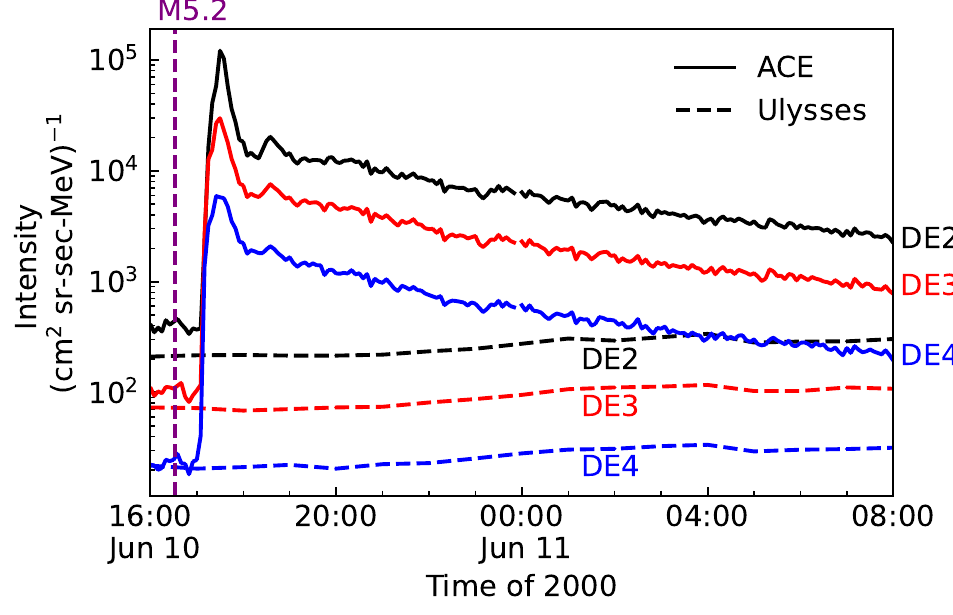
Figure 1. SEP intensities in energy channels of DE2: 53–103 keV, DE3: 103–175 keV, and DE4: 175–315 keV, for the 10 June 2000 SEP event. The solid and dashed lines indicate the energetic electron intensities observed by ACE and Ulysses, respectively. The vertical line indicates the start time of the